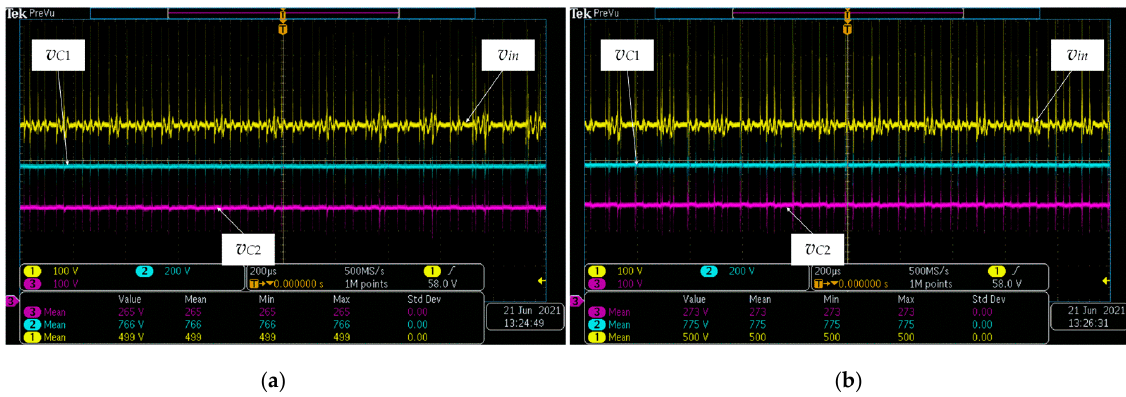
Figure 11. Waveforms of the input voltage, voltage across the capacitor C 1 , and voltage across the capacitor C 2 : the zero-sync method ( a ) and the conventional method ( b ).